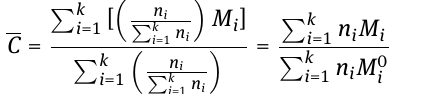
Figure 4: FBRM probe operation principle.